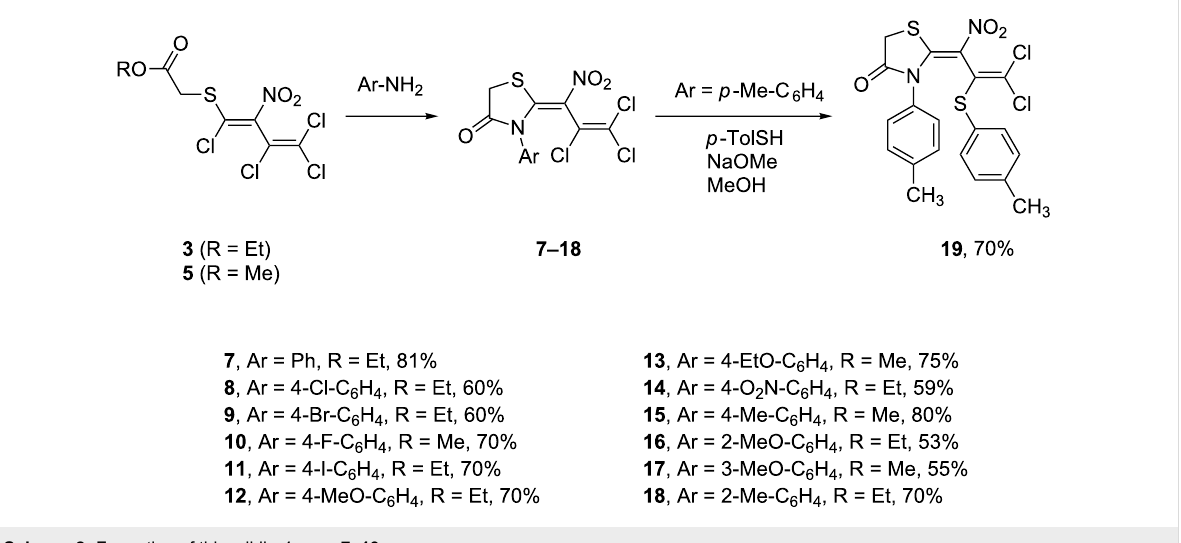
Scheme 2: Formation of thiazolidin-4-ones 7–19 .